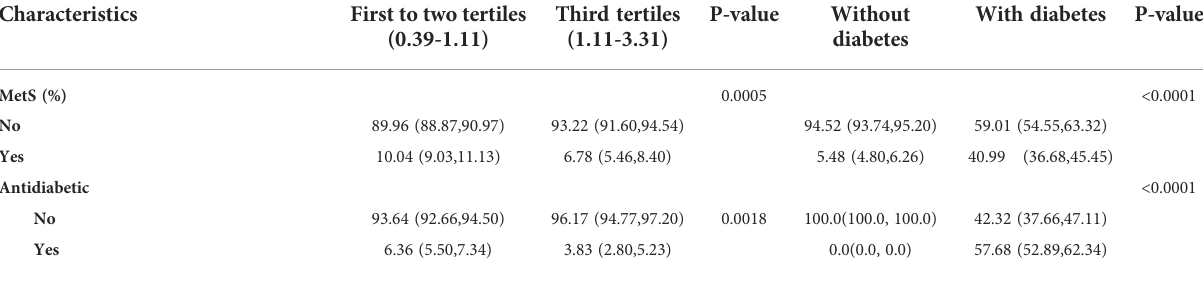
TABLE 2 Individual effect of telomere length (T/S ratio) and diabetes on all-cause mortality. Exposure Non-adjusted